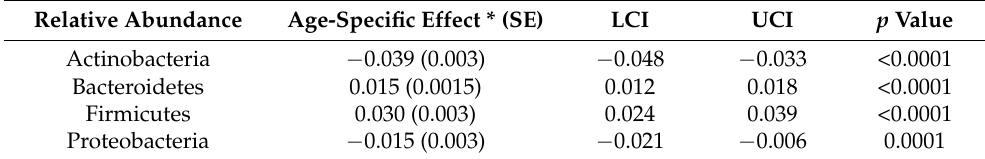
Figure 4. Effect of increasing age on the relative abundance of major taxa: The relative abundance of the four major taxa of the gut microbiota of all children, ( a ) Actinobacteria, ( b ) Proteobacteria, ( c ) Firmicutes, and ( d ) Bacteroidetes, was assessed in QIIME Version 1.5. The effect of increasing age on the relative abundance of these taxa was assessed using a linear mixed-effects model adjusted for gender, residential location, and reported diarrheal episodes. Table 4. Relationship of Age and Relative Abundance of Major